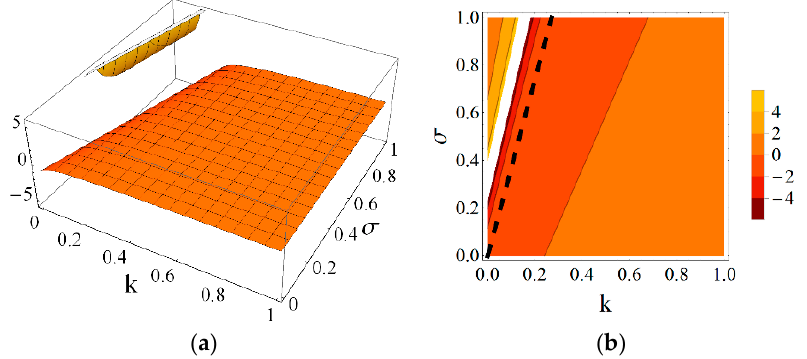
Figure 8. Poisson’s ratio ν 12 = ν 21 : ( a ) 3D plot; and, ( b ) contour